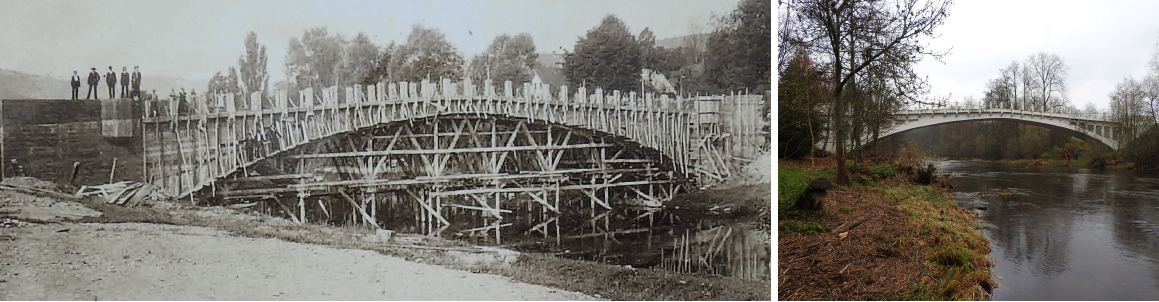
system), of a clear span of 24.000 m. The arch of the bridge is rigidly fixed to the abutments, while